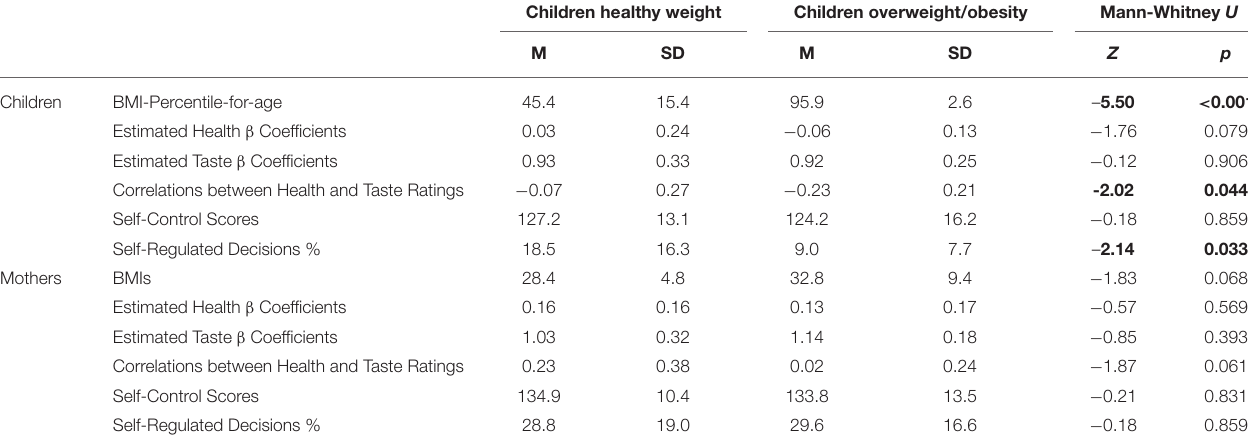
TABLE 5 | Dynamics of food decision-making by children’s weight